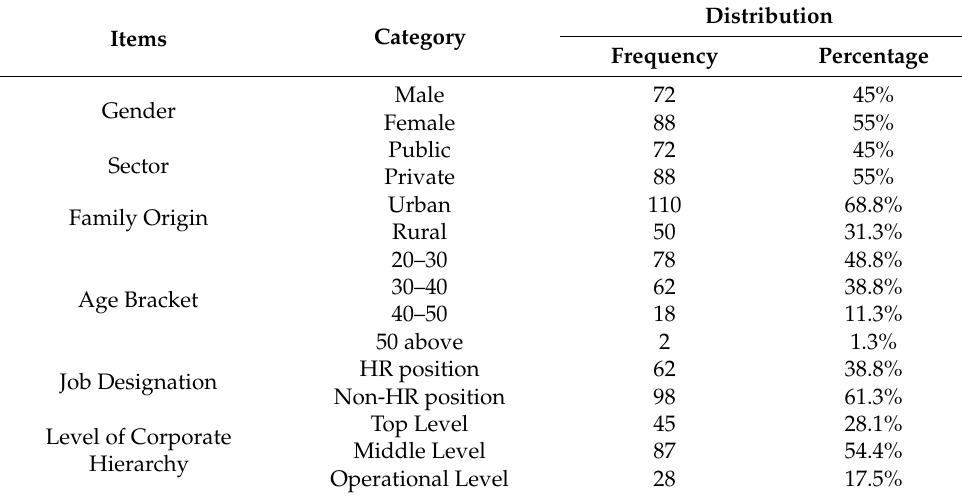
Table 1. Demographic profile of the respondents.